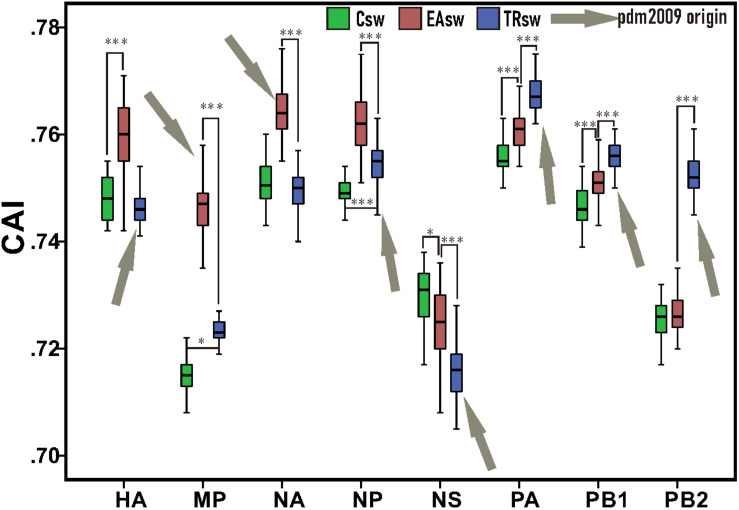
CAI values among each segment belonging to different lineages of SIVs. Green boxes represent values computed from sequences belonging to Csw SIVs and human sequences. Red boxes represent values computed from sequences belonging to EAsw SIVs and human sequences. Blue boxes represent values computed from sequences belonging to TRsw SIVs and human sequences. Arrows marked in gray represent the origin lineage of special gene segment of H1N1/pdm2009. The Wilcoxon Rank Sum Test was used to compare the medians of the CAI values belonging to the different sets of segments of SIVs. ∗p < 0.05; ∗∗
p < 0.01; ∗∗∗p < 0.001.